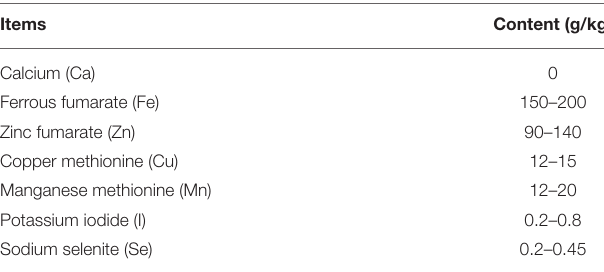
TABLE 2 | Composition of organic trace